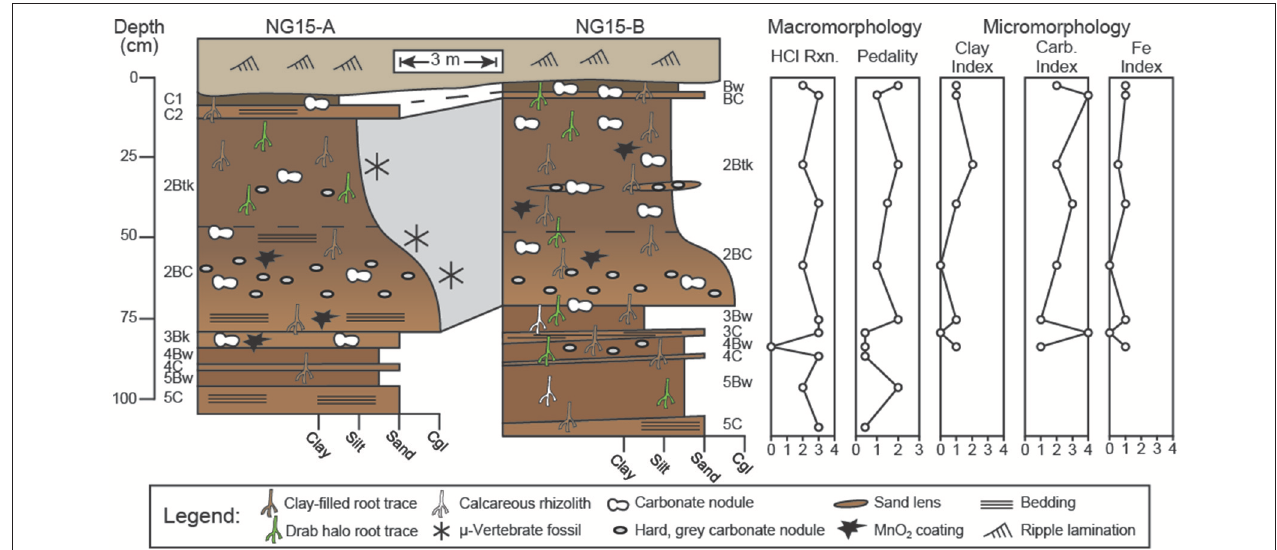
FIGURE 3 | Profiles through Ngira unit 15 (NG15). Macro- and micromorphologic descriptions are for profile NG15-B. Numbers before paleosol horizonation indicate separate, superposed paleosols. Effervescence reaction classes (HCl Rxn.) are reported from field tests, with values corresponding to (0) no reaction, (1) very slight, (2) slight, (3) strong, and (4) violent effervescence (after Schoeneberger, 2002). Pedality classes correspond to (0) massive, (1) weakly formed, (2) moderately formed, and (3) strongly formed peds (after Schoeneberger, 2002). Clay, carbonate, and Fe indices are based on qualitative assessment of thin sections with numbers corresponding to features being (0) absent, (1) few, (2) common, (3) abundant, or (4) omnipresent.